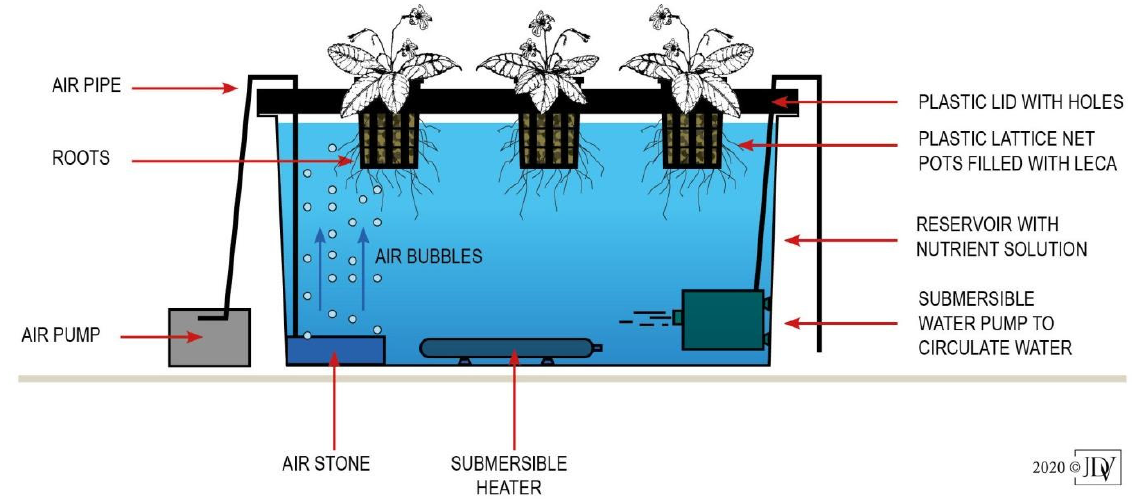
Figure 2. The closed hydroponic deep water culture system used for this study with air stone and circulating pump, and plants in lattice-net pots filled with LECA aggregate held suspended in nutrient solution (Diagram by J.D. Viljoen).